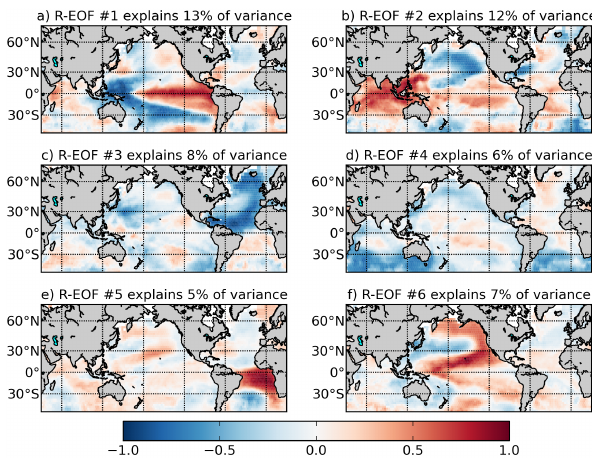
Fig. 4. First six varimax-rotated EOFs estimated from the same data Fig. 4: First six varimax-rotated EOFs estimated from the same dataset as used to build the H-SST set as used to build the H-SST network. network.